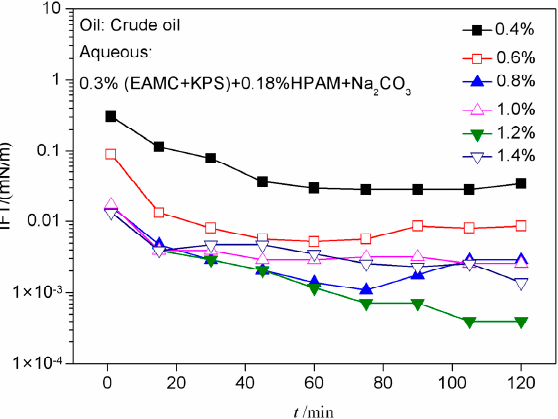
Figure 6. The effect of Na 2 CO 3 on the dynamic IFTs of KPS and EAMC, and HPAM solutions. The Effect of Ca 2+ on the Dynamic IFTs of Chemical Flooding Solutions The effect of Ca 2+ concentration on the IFTs of 0.3 wt % (KPS: EAMC, 8:2) + 0.18 wt % HPAM + 1.2 wt % Na 2 CO 3 solution has been studied and the experimental results are plotted in Figure 7. As the Ca 2+ concentration increases from 100 mg/L to 300 mg/L, the IFT decreases to 10 − 3 mN/m. Then the IFT increases to 10 − 2 mN/m when the Ca 2+ concentration further increases from 400 mg/L to 800 mg/L. The reasons for this result are that if extra Ca 2+ is added into the surfactant solution, it can compress the diffusion electric double layers of the sulfonic acid group of KPS and the carboxylic acid group of EAMC, and the surfactants could aggregate closely at the interface. As a result, IFT decreases. However, when the Ca 2+ concentration is above 400 g/L, the hydrophilicity of the ionic groups of KPS and EAMC is further reduced, and the surfactants at the interface are no longer in their most tightly packed state. Therefore, IFT increases.